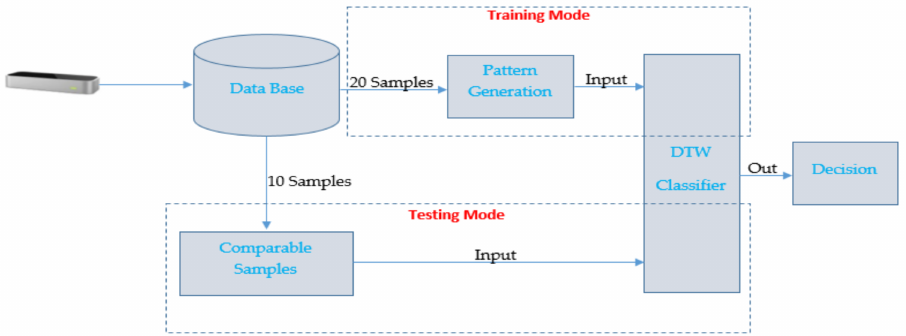
Figure 10. Implemented